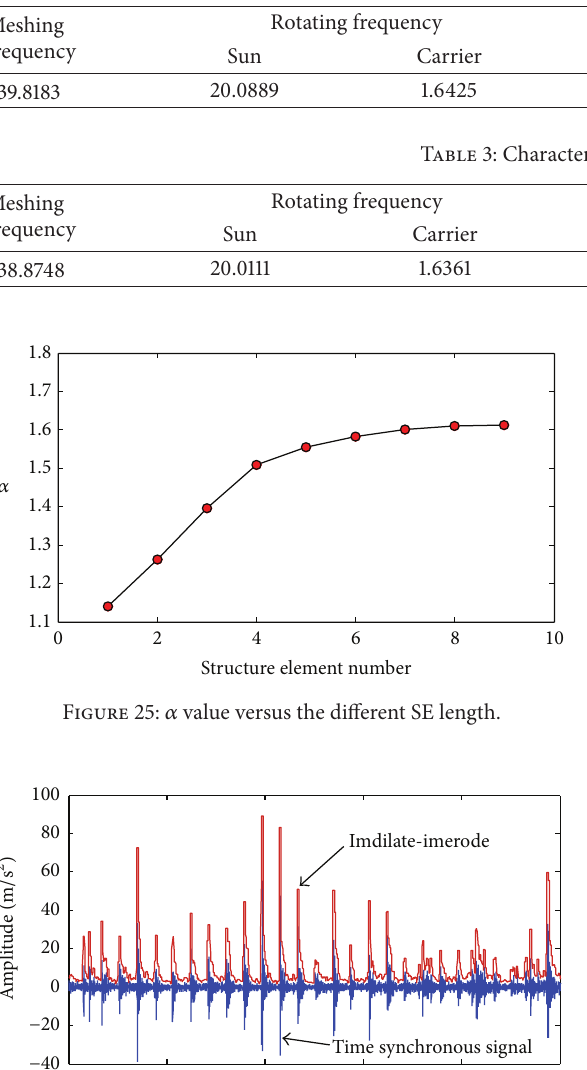
Table 2: Characteristic frequencies (Hz).